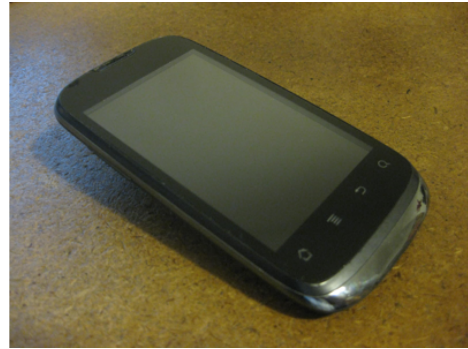
Figure 1: 3D reconstruction based on triangulation.